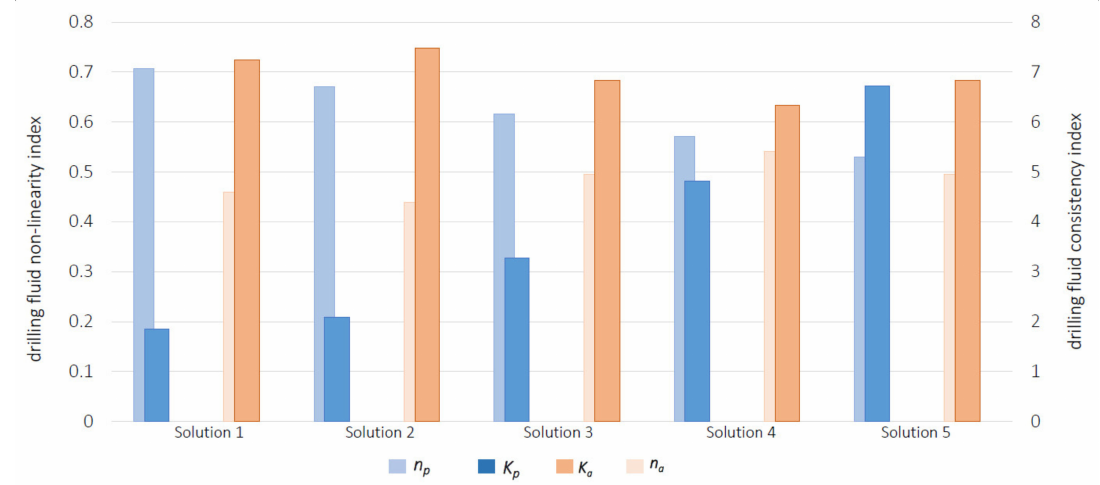
Figure 2. Comparison of the values for the non-linearity index and the consistency index inside the drill pipe and the